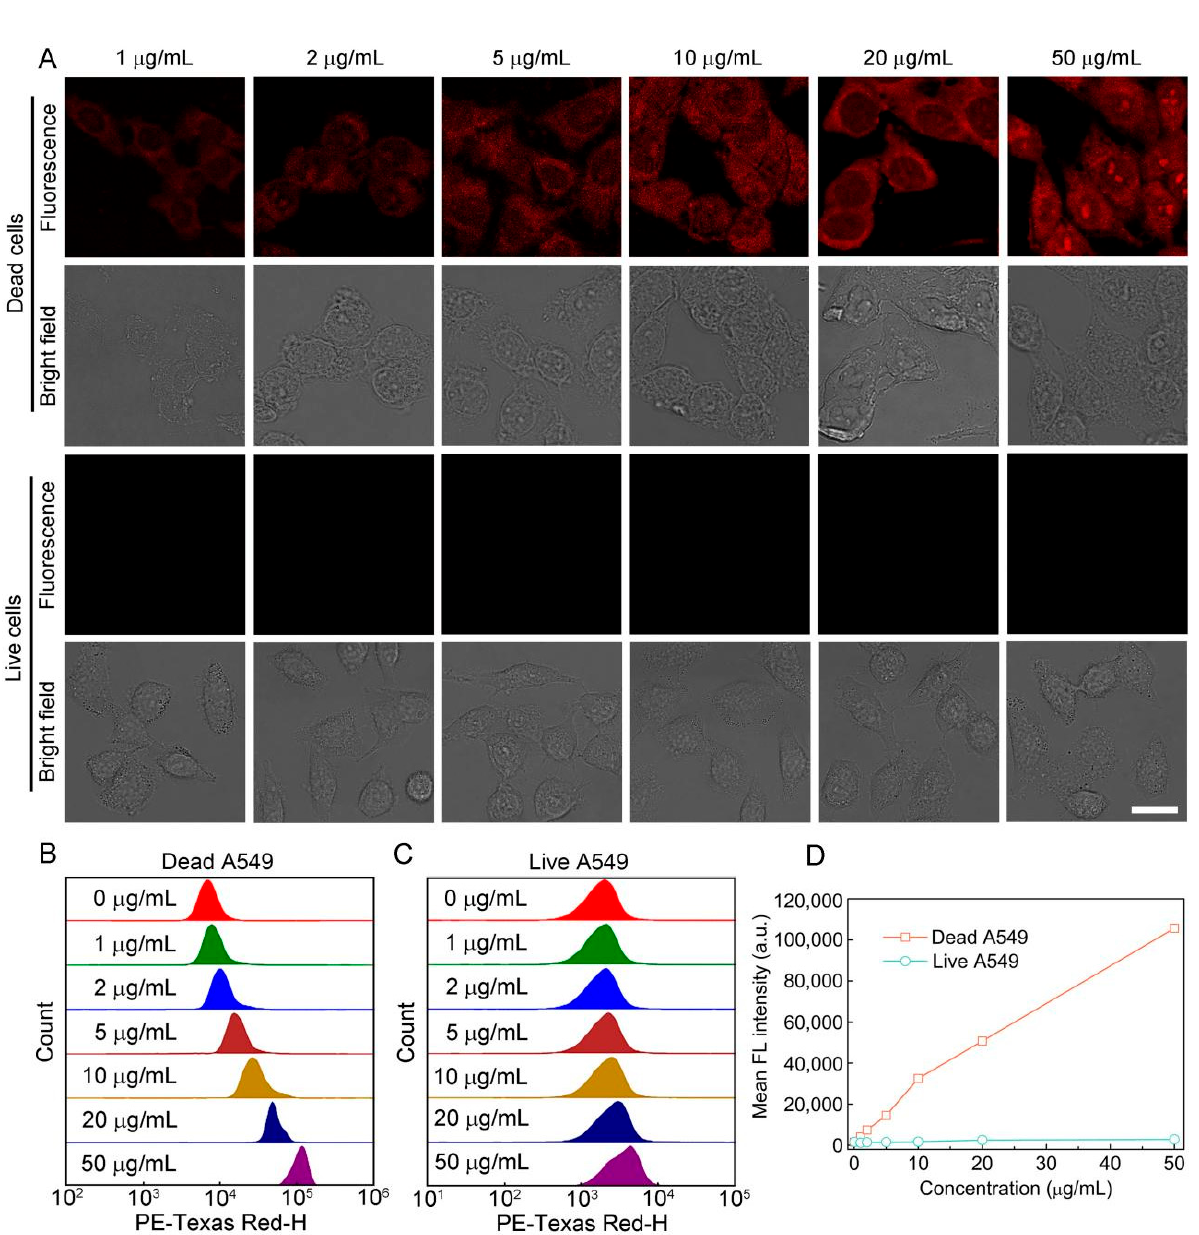
Figure 7. ( A ) Confocal images of dead and live HPAEpiCs incubated with various concentrations of S ‐ OSiNDs for 30 s. Scale bar = 25 μ m 1 . Flow cytometric results of dead ( B ) and live ( C ) HPAEpiCs incubated with different concentrations of S ‐ OSiNDs for 30 s and ( D ) corresponding quantitative mean fluorescence intensities derived from the flow cytometric results.